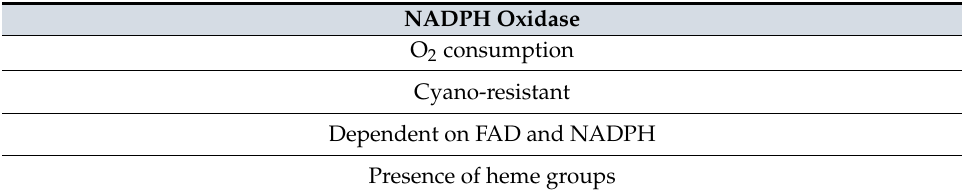
Table 1. Main features shared among the NADPH oxidase family of enzymes.